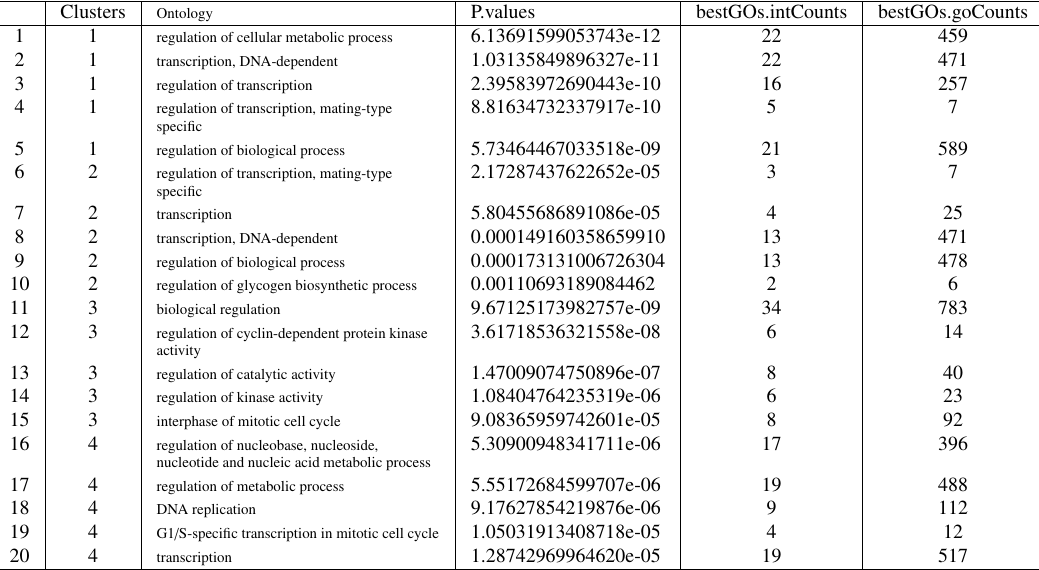
Table 2: GO enrichment analysis results for the four clusters representing four phase-specific